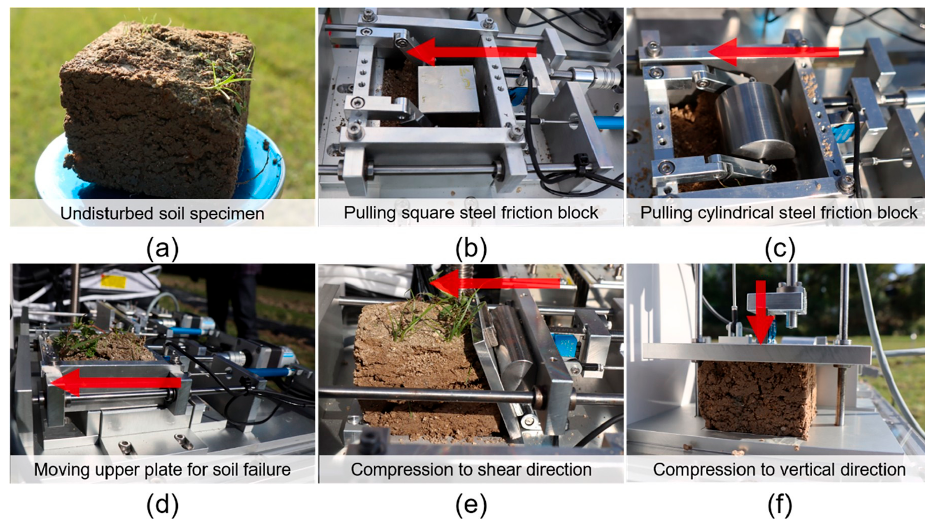
Figure 13. Instruments for in situ measurements of soil mechanical properties: ( a ) sampled undis- turbed soil specimen, ( b ) soil–metal static friction, ( c ) soil–metal rolling friction, ( d ) direct shear test, ( e ) shear modulus, and ( f ) Young’s modulus. Retrieved from Kim et al. [44].